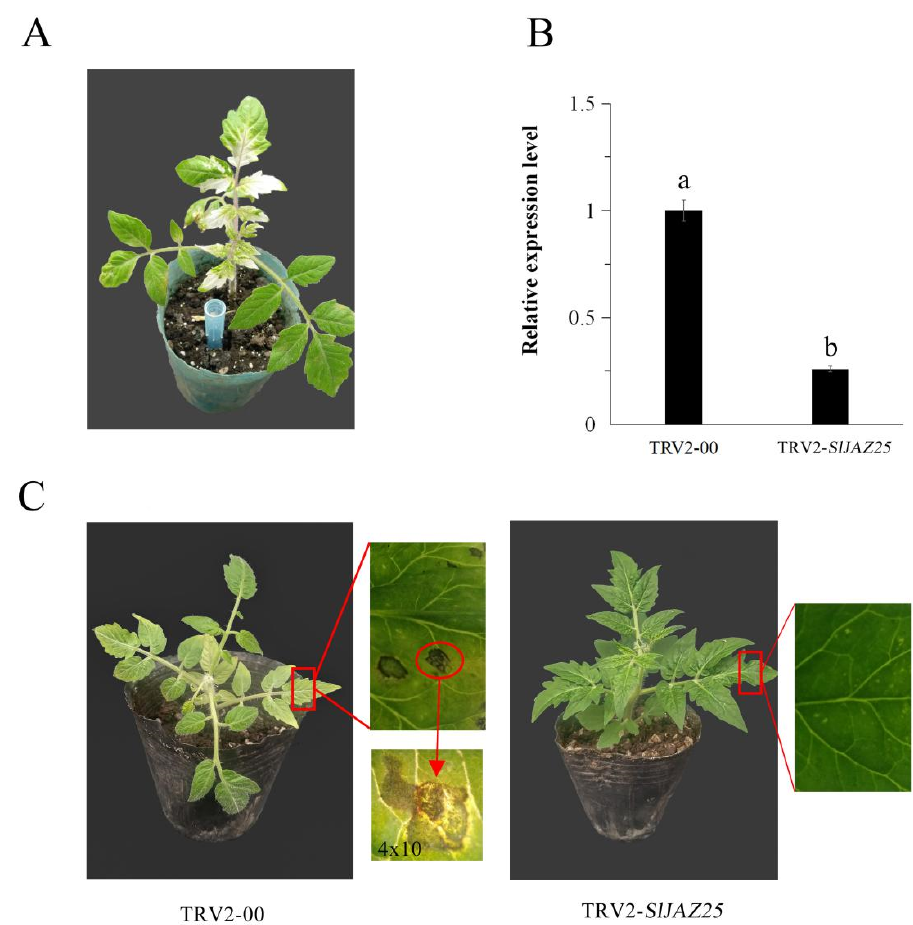
Figure 9. Determination of SlJAZ25 gene silencing efficiency and phenotypes of TRV2-00 and TRV2- SlJAZ25 plants at 3 dpi. ( A ) TRV2- PDS plants with a characteristic photobleaching phenotype at 20 dpi. ( B ) Relative expression levels of SlJAZ25 in TRV2-00 and TRV2- SlJAZ25 plants. ( C ) Phenotypes of TRV2-00 and TRV2- SlJAZ25 plants at 3 dpi. The data presented are the means ± standard deviations of three independent experiments, and the different letters above the columns indicate significant differences at the p ≤ 0.05 level.